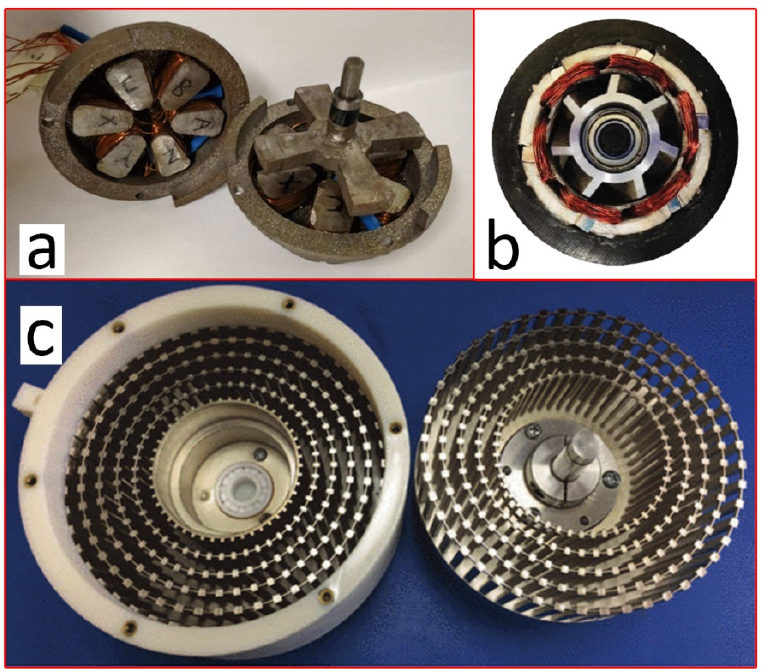
Figure 4. Additively manufactured electrical machines: ( a ) axial flux motor [47], ( b ) integrated fan motor reprinted with permission from Ref. [48]. Copyright 2021 Elsevier, ( c ) electrostatic motor [49].